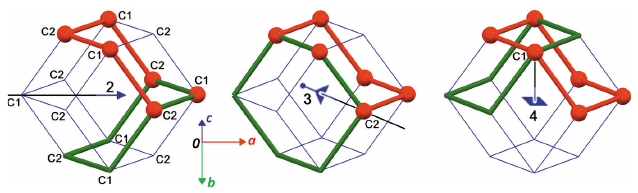
Figure 4 The rhombic dodecahedron (blue edges) describing the 24 disordered positions of cyclohexane at 255 K. On the left, atom labels are given, omitting their symmetry codes for clarity. Red and green molecules are related by twofold (left), threefold (middle) and fourfold (right) rota- tions. The twofold axis is viewed in the plane of projection, while the three- and fourfold axis are inclined with respect to that plane. The projection is viewed along [012], and the unit-cell origin is coincident with the centre of the